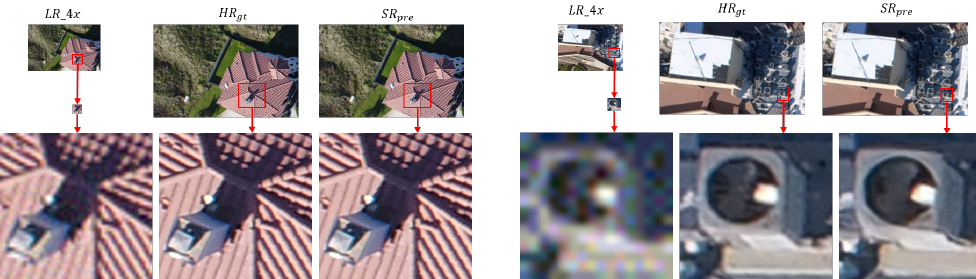
Figure 9. Illustration of the qualitative comparison between the predicted SR image and corresponding LR and ground truth HR images for two test images.